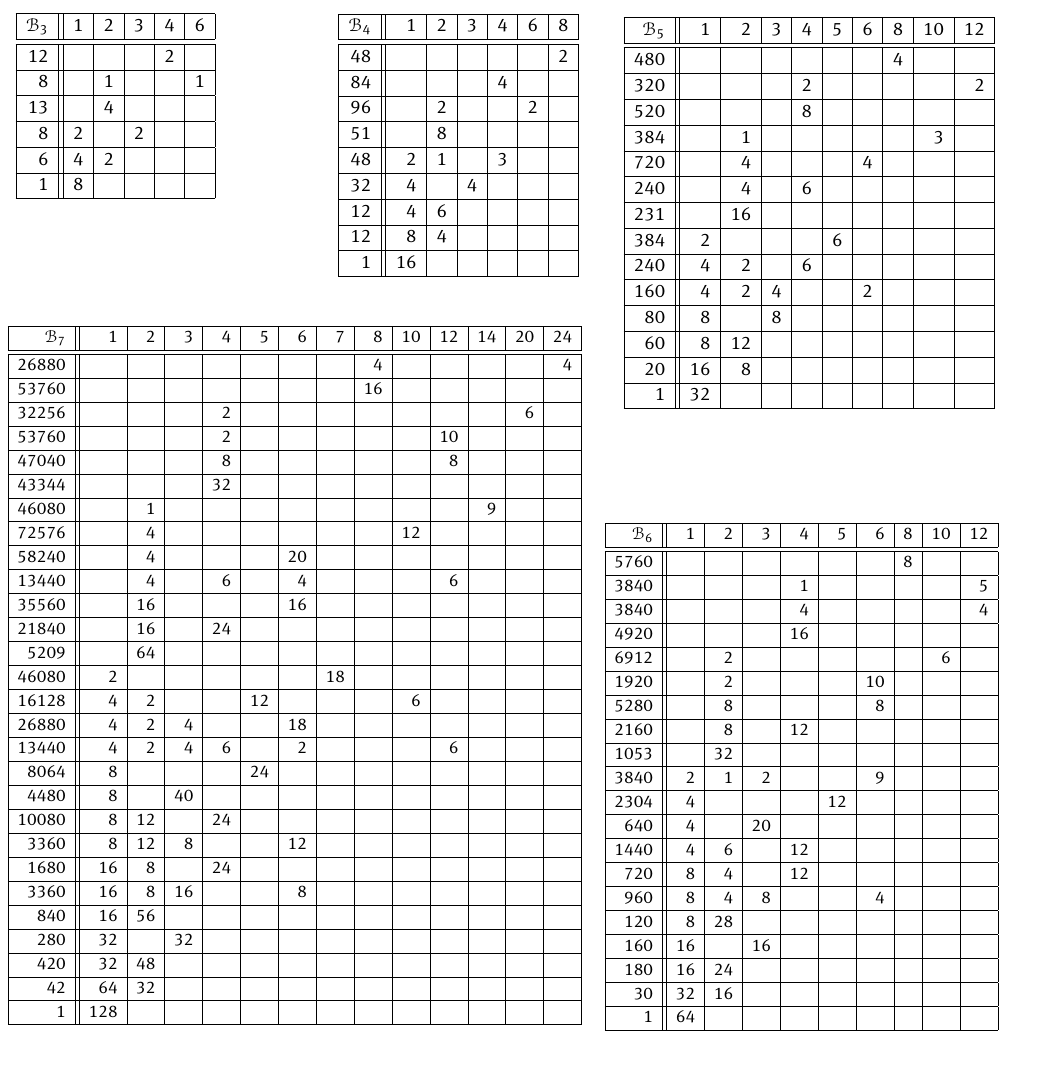
Table 10: The cycle indices Z 3 , Z 4 , Z 5 , Z 6 and Z 7 in condensed tabulated